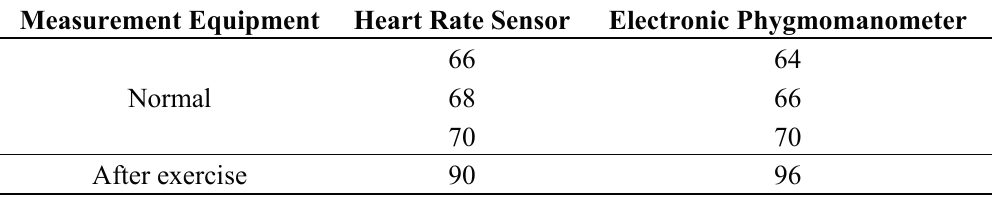
Table 1. Result of the heart rate sensor and commercial electronic